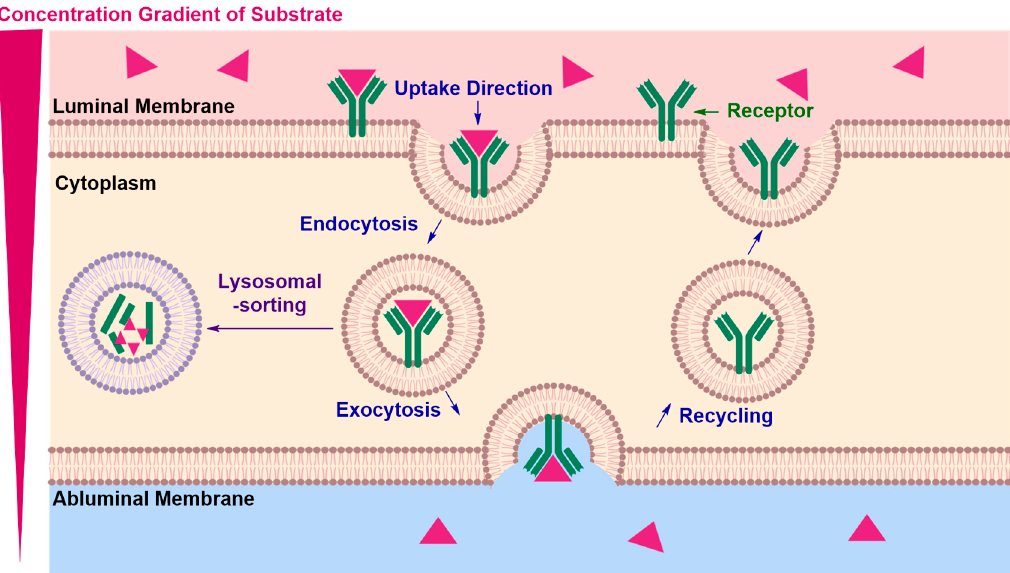
Figure 14. Postulated mechanism of receptor-mediated transcytosis (RMT). The mechanism proceeds with a receptor–vector recognition event at the luminal membrane, followed by endosome formation and transport to the opposite abluminal membrane from which the cargo is exocytosed. Endosomal escape is the limiting step, the obstruction of which requires further understanding of receptor binding dynamics that can control intracellular transport mechanisms. Insulin Receptor (IR)